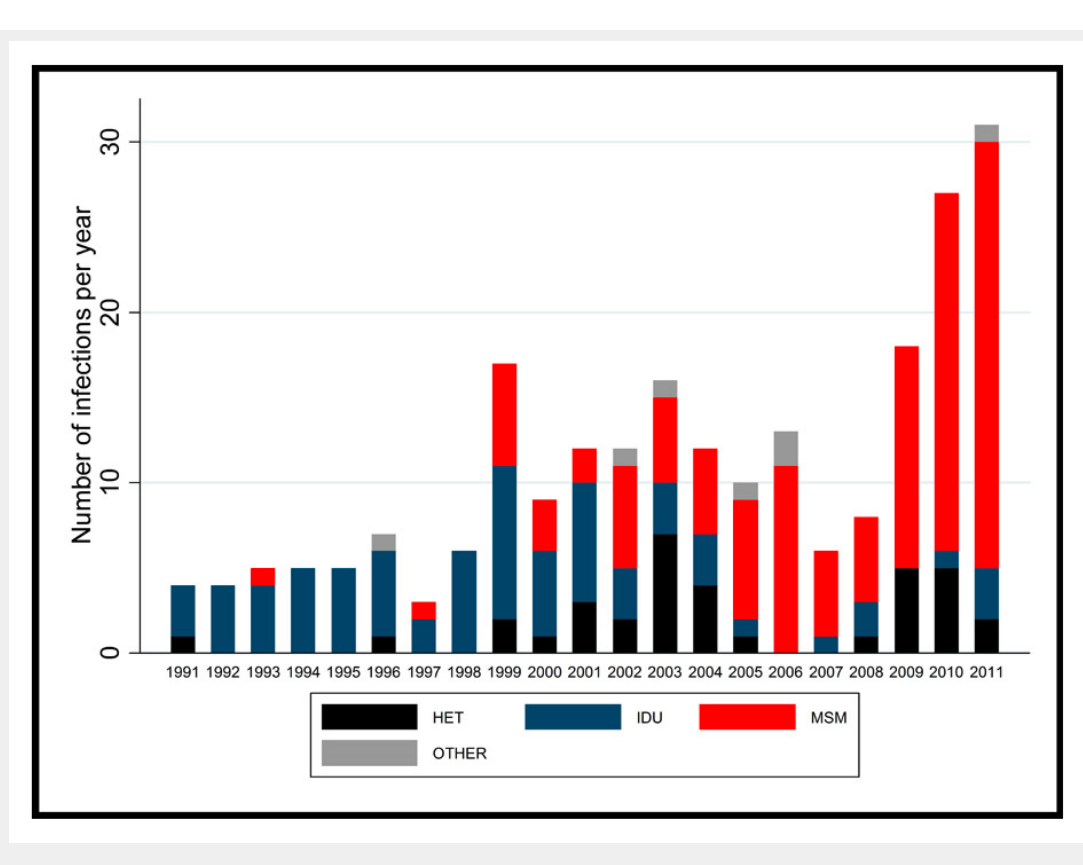
Figure 1 Incident HCV infections by transmission route in the Swiss HIV Cohort Study. HET = heterosexual; IDU = injection drug use; MSM = men who have sex with men (refer to most likely mode of HIV